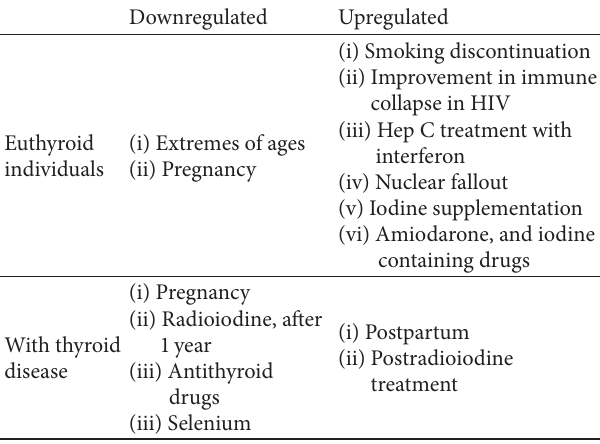
Table 2: Regulation of thyroid antibodies in euthyroid and individ- uals with active thyroid